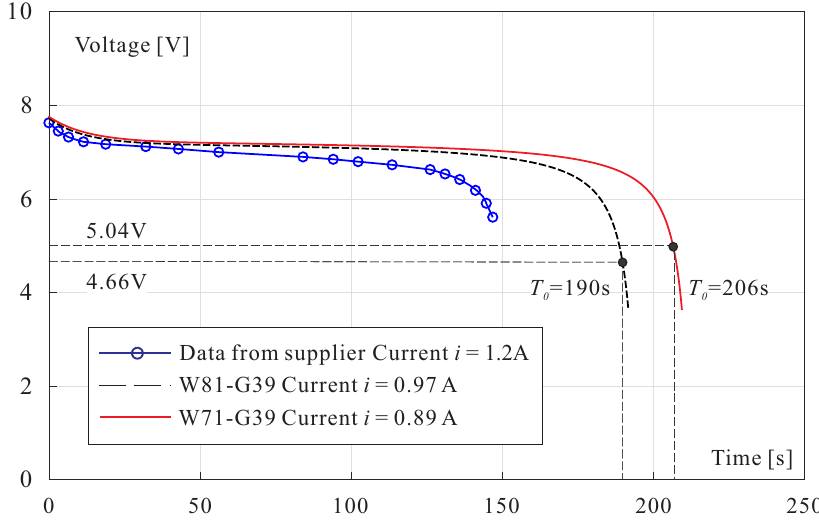
Figure 12. L = 20 gr. Discharge curve of two batteries B2 in series for a discharge rate of 0.97 A ( T 0 = 190 s) and 0.89 A ( T 0 = 206